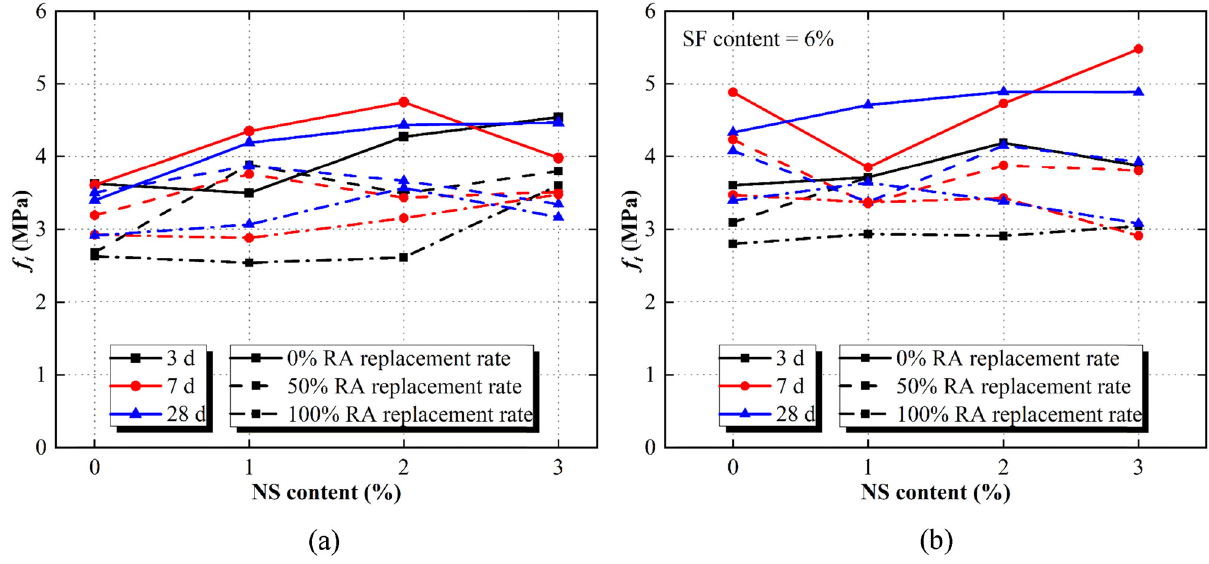
Figure 12: E ff ect of SCMs contents on the split tensile strength: ( a ) NSRAC and ( b )